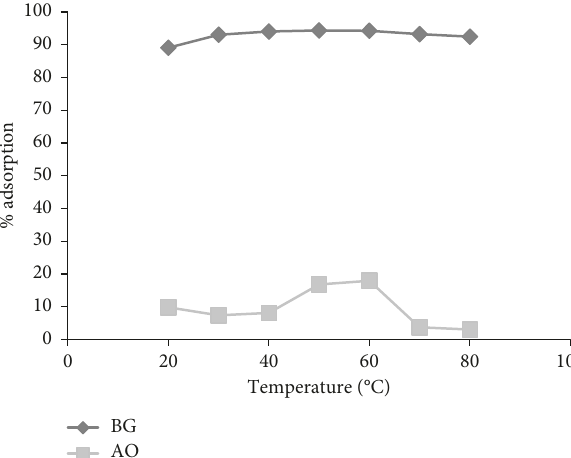
Figure 6: Graphical illustration of relative temperature effect on BG and AO-74 dye elimination by PR leaves.